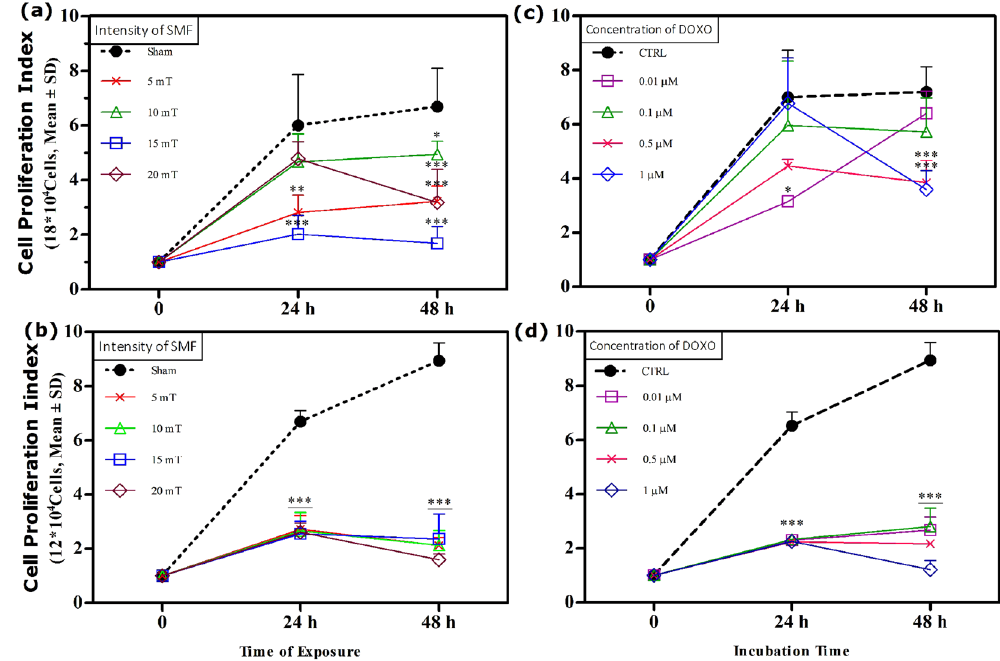
Figure 3. The cell proliferation results of ( a , c ) MCF-7 and ( b , d ) HFF cells exposed with SMF at different intensities (5, 10, 15 and 20 mT) and incubated with DOXO at different concentrations (0.01, 0.1, 0.5 and 1 μ M) for two exposure times (24 and 48 h). The results are expressed as the fold-value of proliferation rate. Data are shown as mean ± SD (n = 3). * P < 0.05; ** P < 0.01; *** P < 0.001 . Significant difference relative to unexposed cells (sham, CTRL) ( *** ; refers to all cell groups) (5 × 2 factorial ANOVA flowed by post-hoc Newman–Keuls multiple comparison